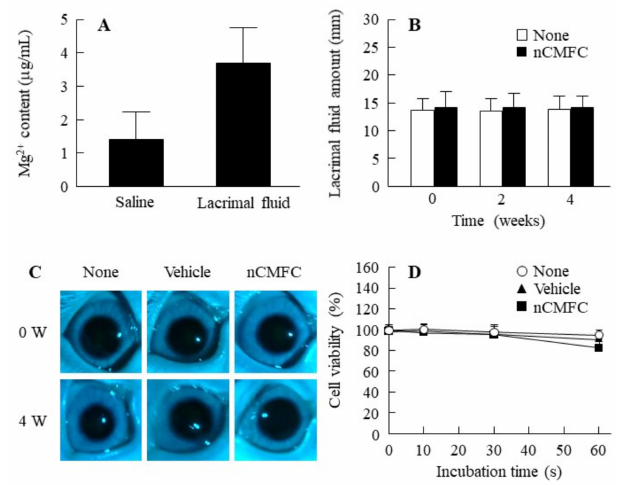
Figure 2. Effect of nCMFC on rabbit eyes. ( A ) Solubility of MH in nCMFC in saline and lacrimal fluid; ( B ) changes in amount of lacrimal fluid after repetitive instillation of nCMFC for 4 weeks (twice/day); ( C ) image of rabbit eye after the repetitive instillation of nCMFC for 4 weeks (twice/day); ( D ) viability of human corneal epithelial cell line cells (HCE-T) cells treated with nCMFC. None, non-treated groups. Vehicle, vehicle-instilled groups. nCMFC, nCMFC-instilled groups. n = 6–12. Solubility of MH in nCMFC in lacrimal fluid was low (0.00037%), and the behavior of lacrimal fluid (balance of secretion and excretion) was similar between rabbit eyes instilled with or without nCMFC. In addition, the corneal toxicity of nCMFC was not observed in the rabbit cornea and HCE-T